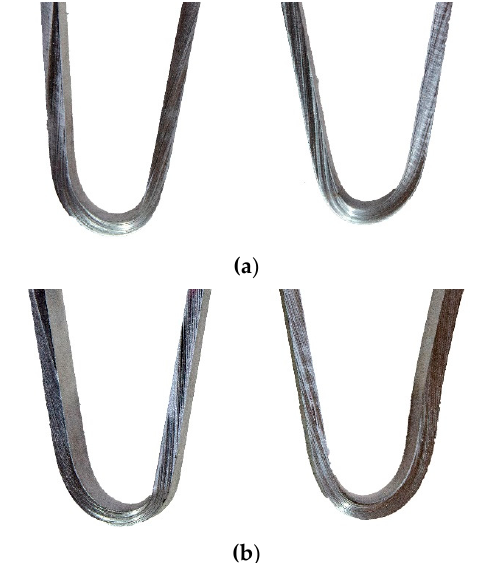
Figure 4. Specimens after bending tests: ( a ) bending from the face and ( b ) bending from the root.